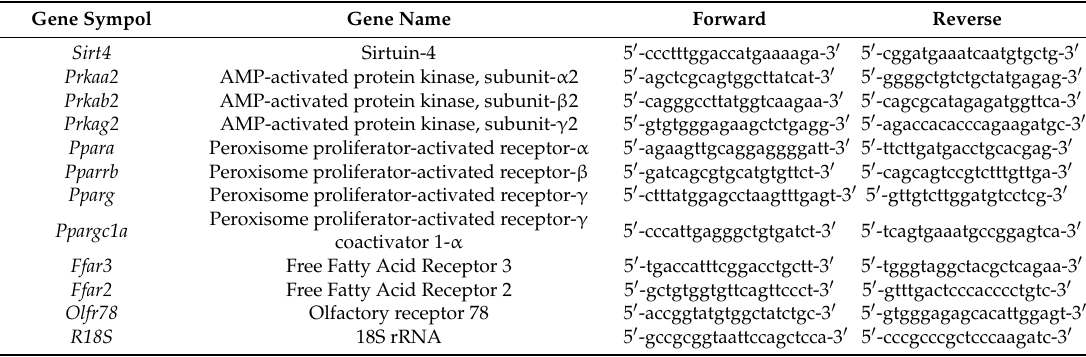
Table 1. Quantitative real-time polymerase chain reaction primers